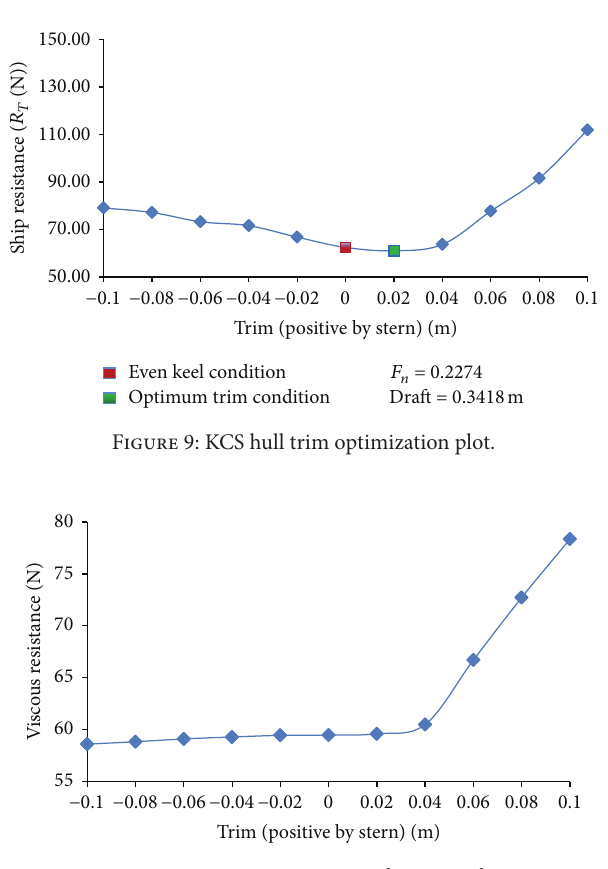
profiles in even keel condition and different trim conditions are presented in Figure 12.